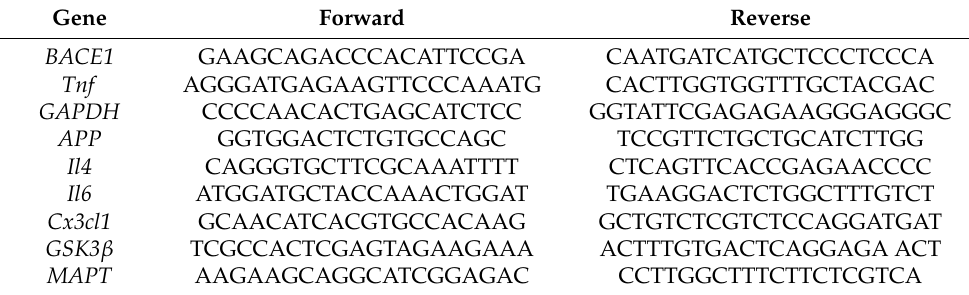
Table 1. List of Primers used for mRNA qPCR.